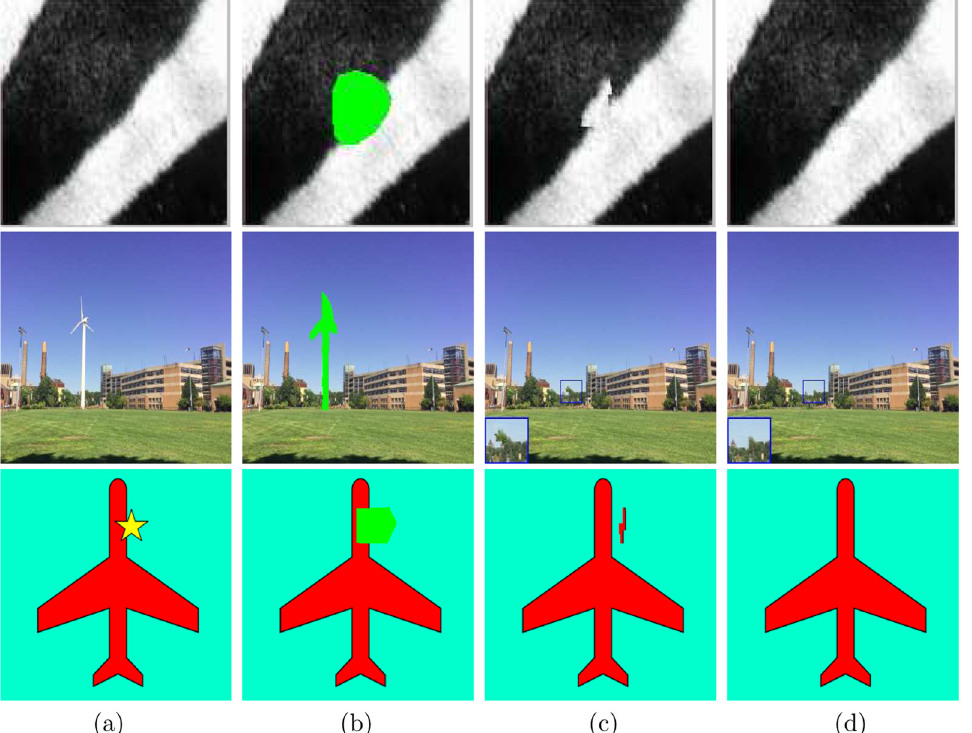
Fig 5. Test images from top to bottom: “ zebra ” (with the size of 115 × 138), “ windmill ” (311 × 380) and “ plane ” (277 × 302). (a) The original images; (b) The original images with the green target regions; (c) and (d) are the inpainted images by the method in [23] and our method, respectively. The first phase of the proposed method executes 16, 45 and 10 steps, respectively. Readers are recommended to zoom in all images for better